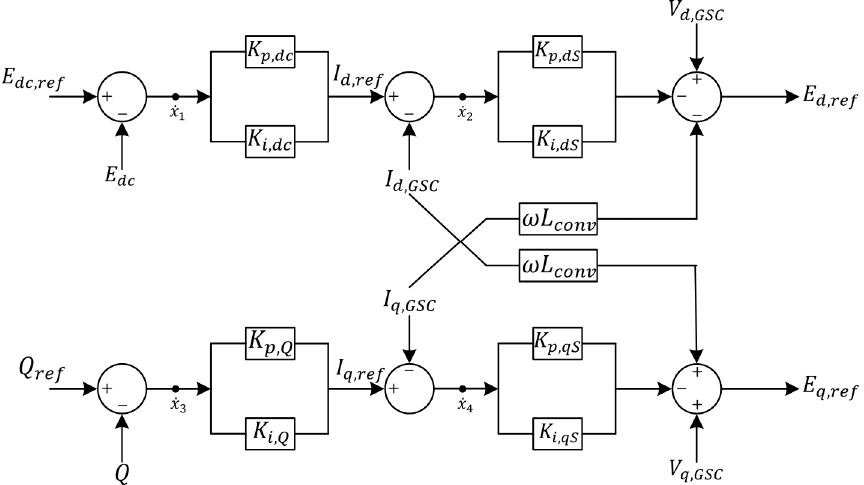
Figure 8. Grid-side converter control of a WTG T3 + T4. Energies 2020 , 13 , x FOR PEER REVIEW